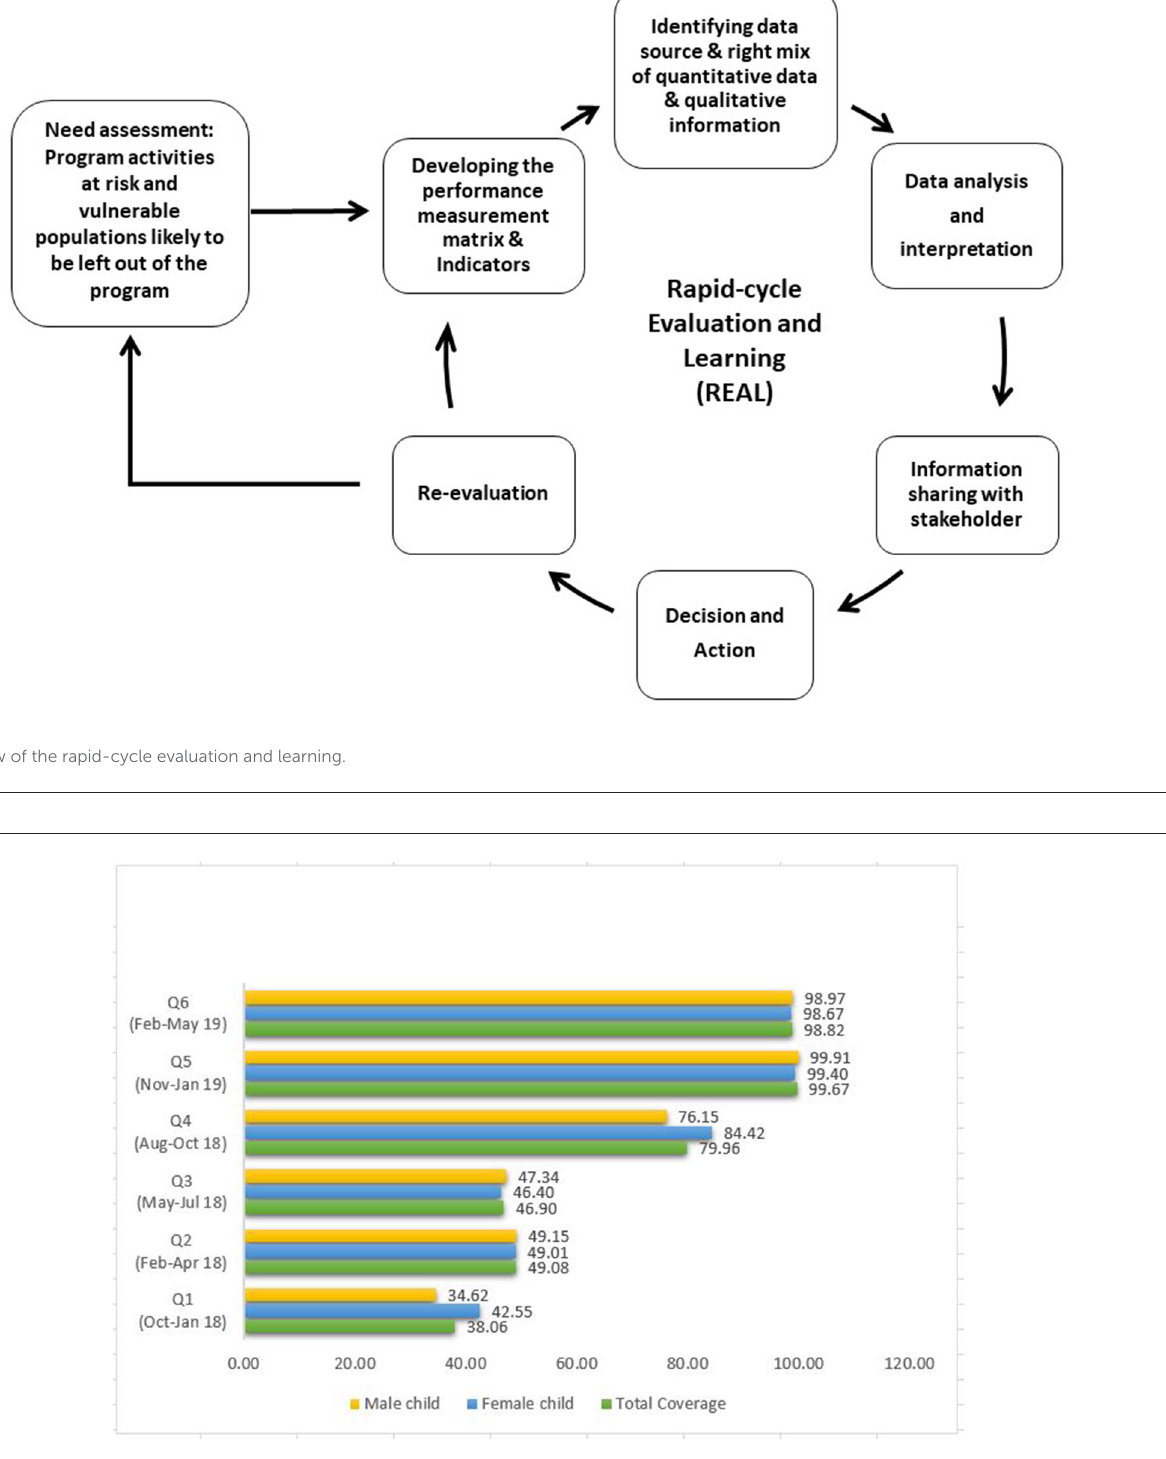
FIGURE2 Percentage coverage with quarter review